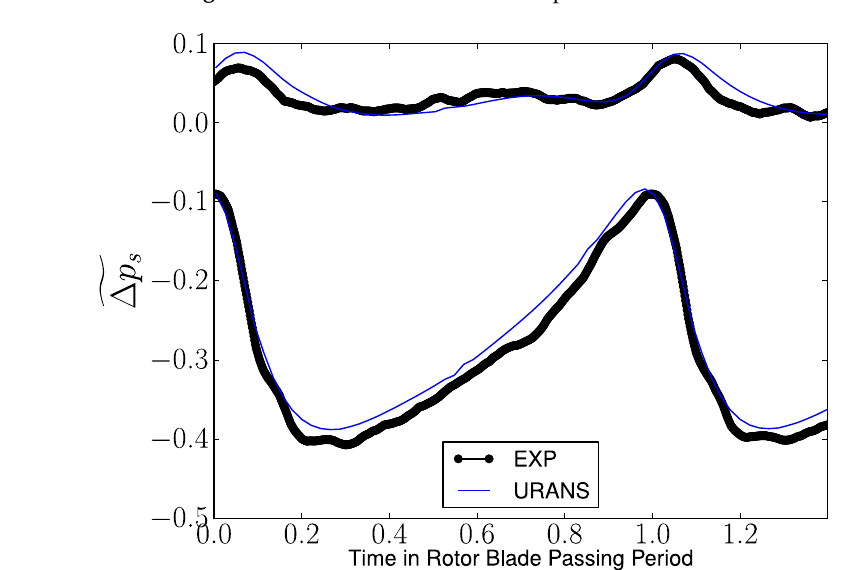
Figure 5. Pressure fluctuations at the rotor LE and TE at peak